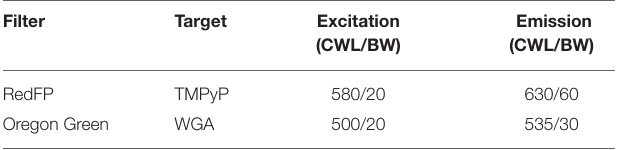
TABLE 1 | Setup of the used fluorescence filters and their excitation and emission wavelengths, as well as the corresponding photosensitizers, that were examined by fluorescence microscopy.